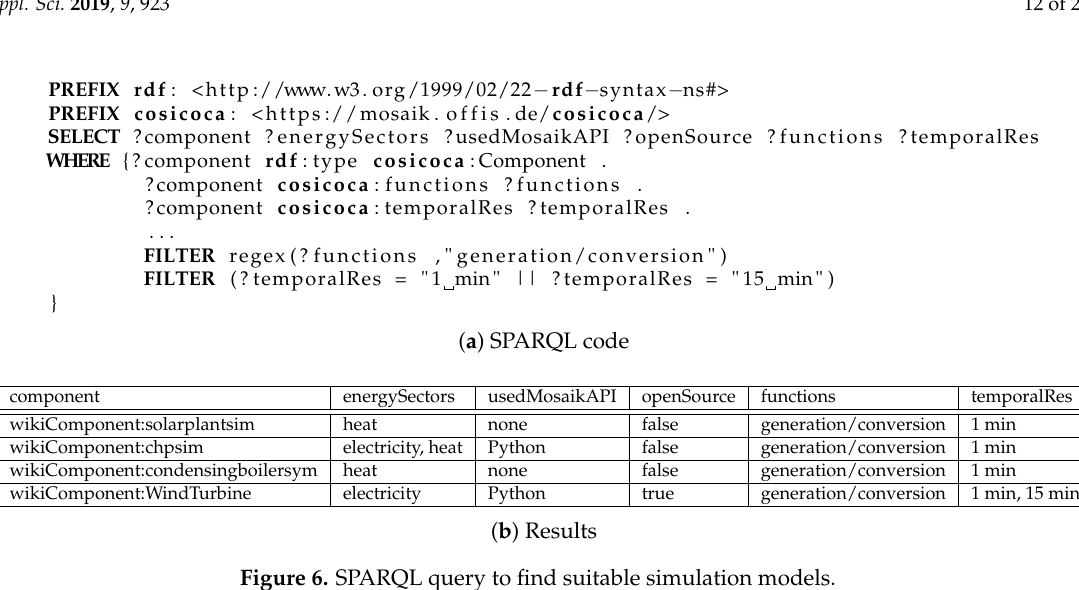
Figure 6. SPARQL query to find suitable simulation models.